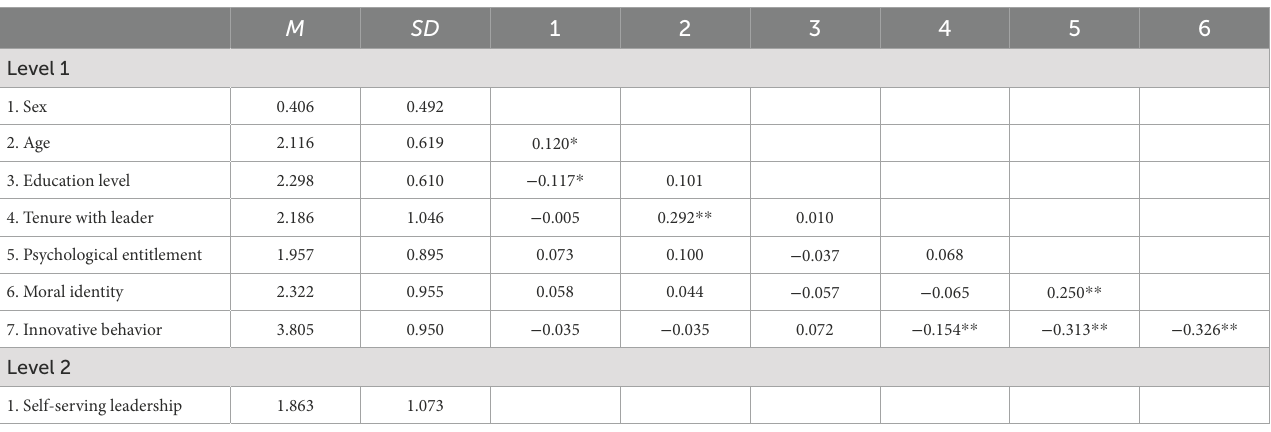
TABLE 3 Results of descriptive statistical